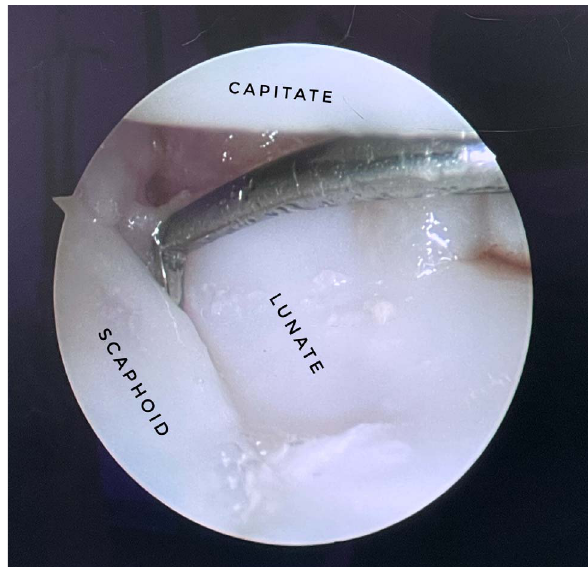
Figure 3. The Geissler classi fi cation [19] is commonly used to assess carpal instability and SL injuries. This fi gure shows a 3 – 4 portal visualization of the SL, with a presence of a gap between carpal bones that is less than the width of the probe, representing grade 2 of interosseous ligament injury according to Geissler ’ s classi fi cation. SL, Scapho-lunate